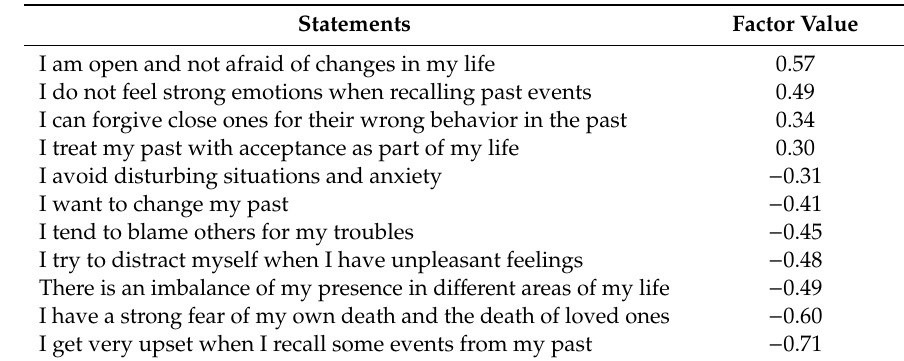
Table 2. Factor “Attitude to the